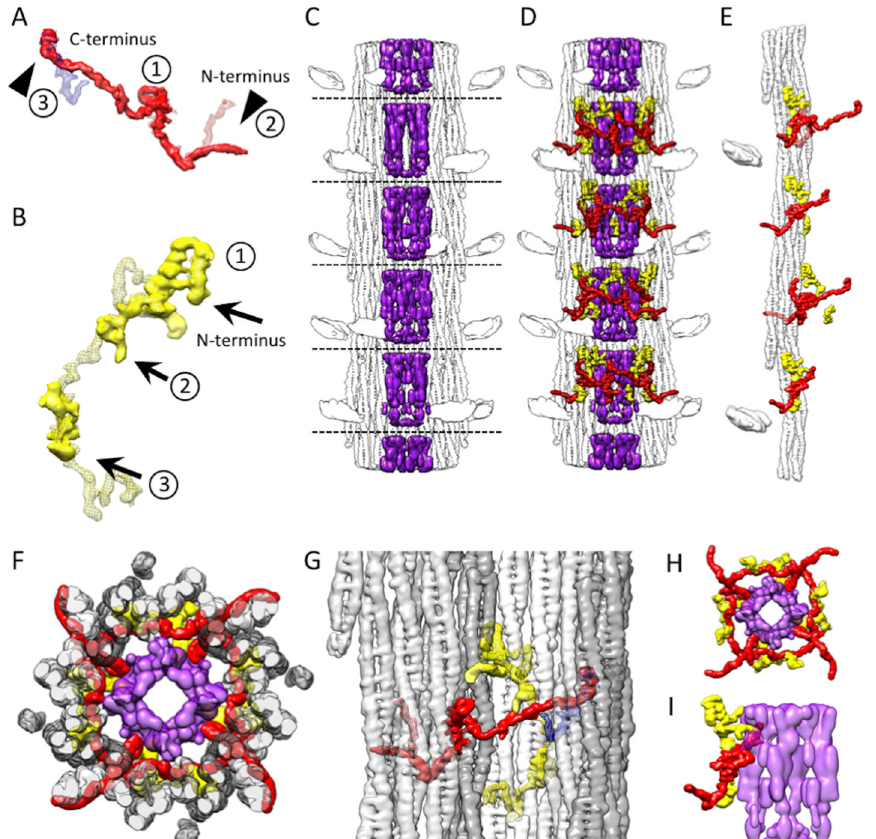
Figure 5. Three non-myosin densities in Bombus thick filament. ( A ) Bombus flightin molecules (red, solid) are similar among all three species with a small folded domain (labeled 1) in the middle corresponding to the WYR domain [28], a partially ordered extension outside of the filament backbone (labelled 2) on one side of the WYR domain and an extension on the other side (labelled 3). At the N-terminus (labelled 2) Lethocerus (red, mesh) shows the largest extension outside the filament backbone, stabilized by contacts to its proximal S2 [8]. Drosophila has the same feature but with a shorter extension [13] corresponding to only the overlap between Lethocerus and Bombus . The flightin N-terminal extension seen in Bombus leaves the backbone density at a different angle (solid red surface). The flightin C-terminus (labelled 3) overlaps a density (blue, mesh) from a Lethocerus thick filament reconstruction. ( B ) Bombus myofilin (yellow, solid) shows a novel structure, with two densities, that overlap and contact the Lethocerus myofilin density (yellow, mesh). ( C ) The Bombus paramyosin (purple, solid) in the central core. ( D ) The distribution of all three non-myosin proteins in the context of the thick filament. ( E ) Flightin and myofilin decorating a single curved layer. ( F ) The top view of a full crown slab containing all three non-myosin proteins. ( G ) Side view showing the relationship of the three non-myosin proteins to the five curved layers colored white, light gray and dark gray. ( H ) Top view and ( I ) side view showing the relationship of flightin and myofilin with the paramyosin core. Both myofilin and flightin appear to contact paramyosin.